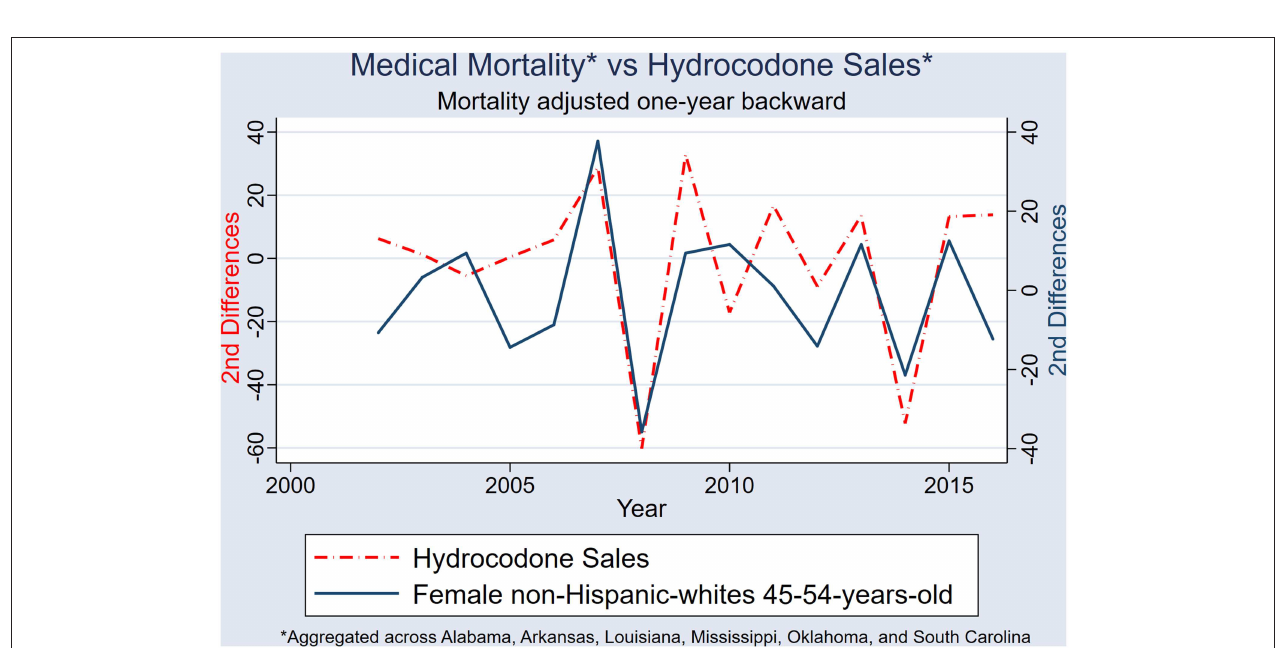
with various causes of drug-related mortality. At the state-level in North Carolina, a temporal trend in the sales of prescription opioids correlated with temporal trends in patient emergency department visits for opioid overdoses